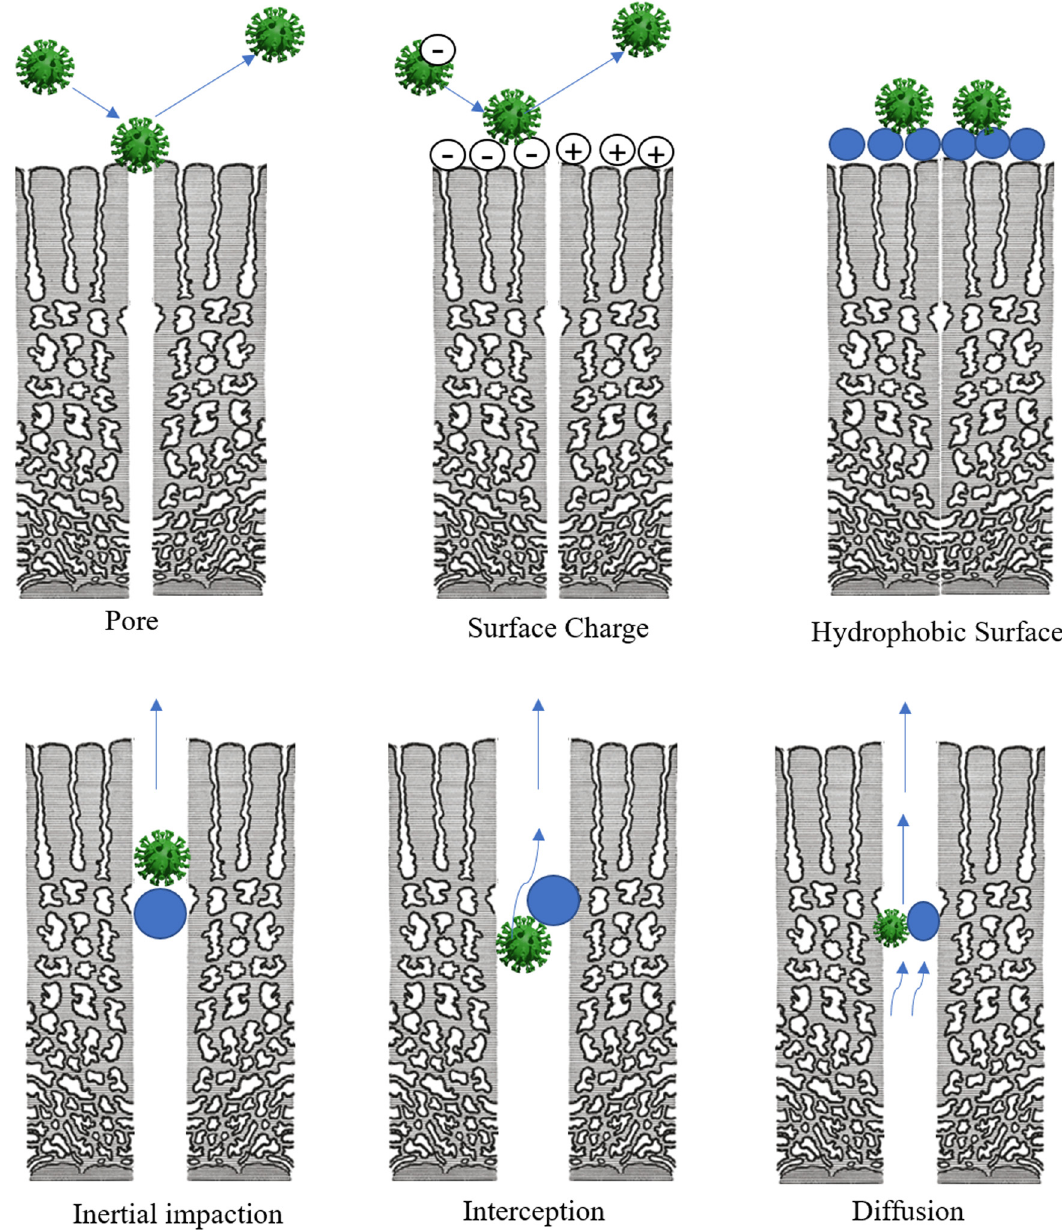
Figure 4: A schematic diagram for membrane mechanisms for removing viruses from